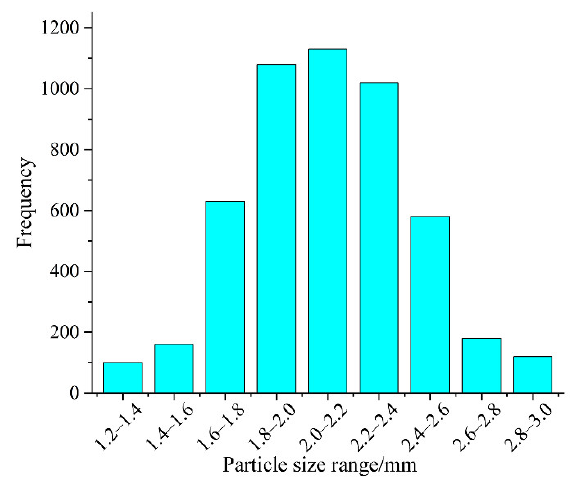
Figure 5. Equivalent diameter distribution of fertilizer particles.